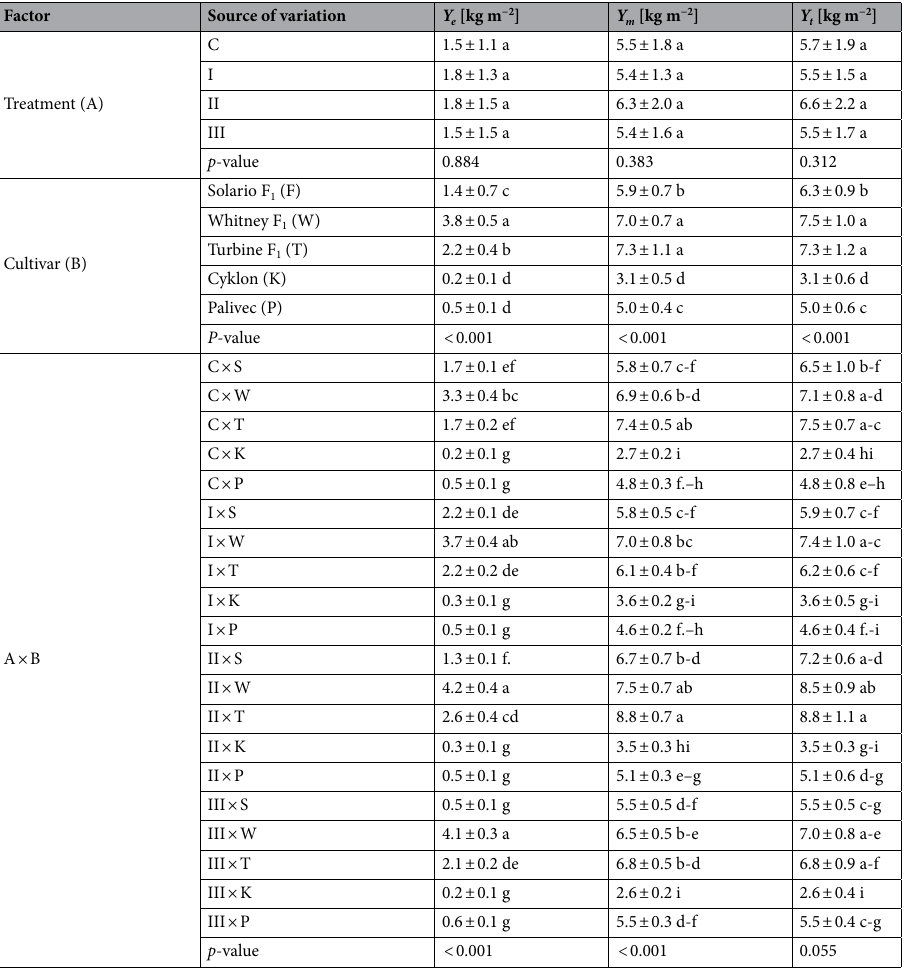
Table 2. Effect of the combined application of biostimulants on fruit yield (mean values ± standard deviations) in the analyzed cultivars of Capsicum annuum . Means followed by different letters are significantly different for each parameter (the level of significance, the p -value, is shown in the table). Y e -early yield, Y m -marketable yield,